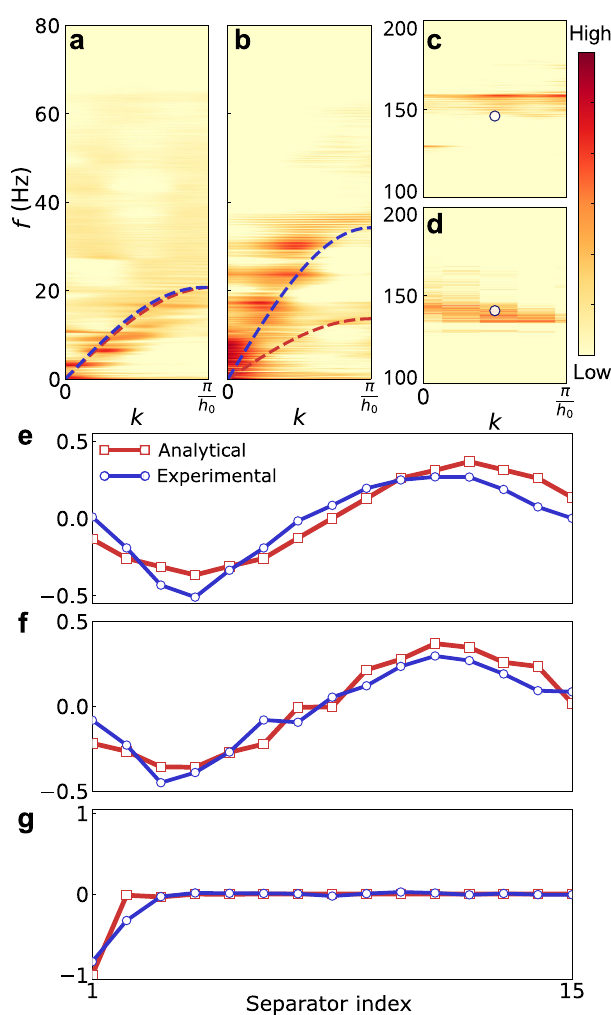
Fig. 4 Experimentally acquired dispersion relationships from chirp signal response of the 16-unit-cell dimer Kresling origami lattice. The input chirp signal is given for 10 s, sweeping the frequency from 0 to 180 Hz. For each case, the lattice is quasi-statically twisted for a , c 0° (natural condition), and b , d 15° twist. Red and blue dashed lines represent the analytically predicted fi rst and second branches, and the circle symbol represents the 15th eigenmode (topological mode) within the band gap. The axial displacement component of the normal modes is extracted for both linear eigenanalysis prediction and experiment. e Natural condition, ¼ 15 (cid:3) , the eighth normal the fourth normal mode. f Twisted condition, φ b mode. g Natural condition, the 15th mode (topological mode). The experimental normal modes are extracted via SVD-based Fig. 3d), and changes to the left boundary when twisted positively (label (iii) in Fig. 3d). Similarly, for the 16th mode shown in the right panel of Fig. 3d, the edge state changes its localization site from left to right as the twist angle transitions from negative to positive.